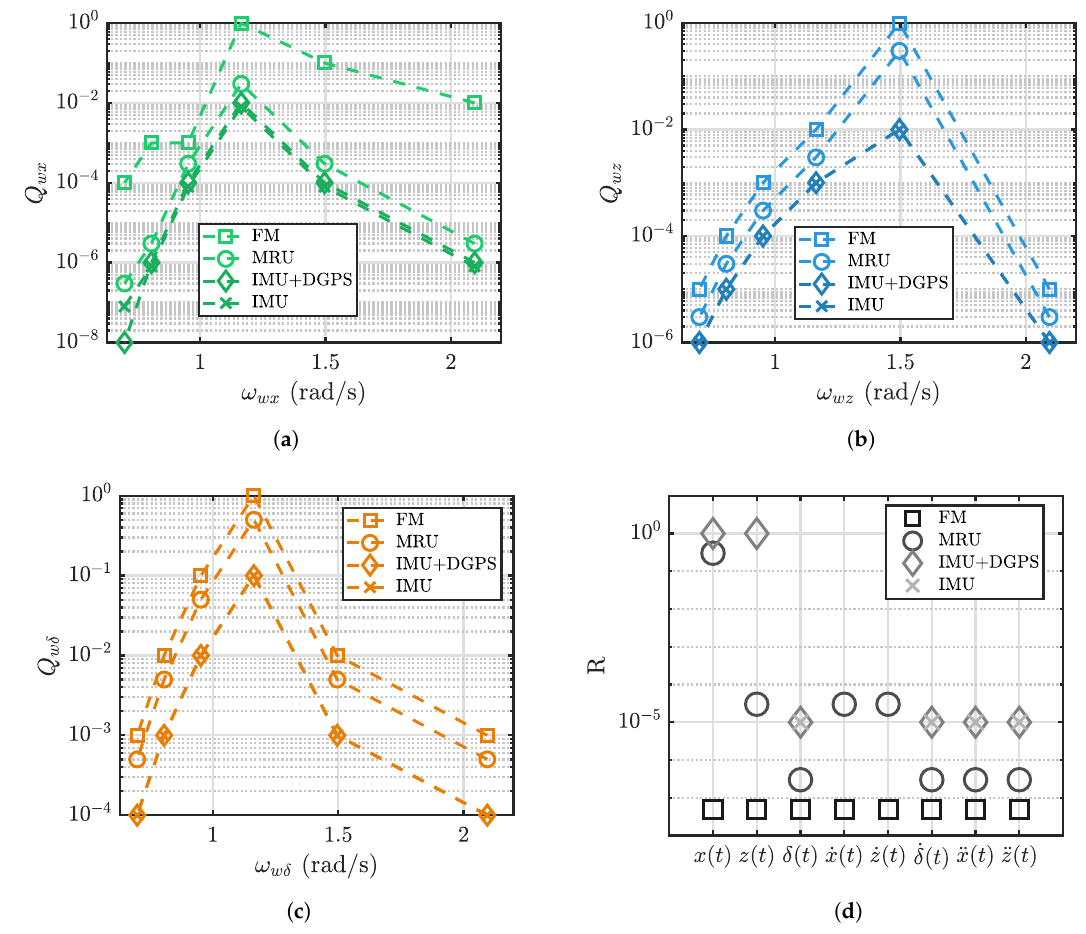
Figure 9. Q and R coefficients for each measurement framework and WEF compoenents: Q values for ˆ F ˆ F ˆ F wx ( a ), Q values for wz ( b ), Q values for w δ ( c ) and R values. ( a ) Q coefficients of surge components; ( b ) Q coefficients of heave components; ( c ) Q coefficients of pitch components; ( d ) R